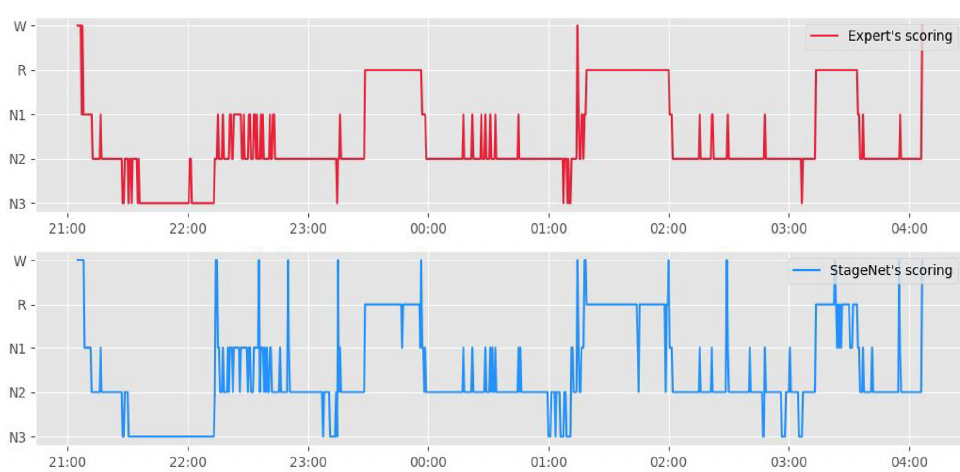
Figure 3. Hypnogram comparison between manual sleep-stage scoring and automated sleep-stage scoring based on a deep learning algorithm (StageNet).